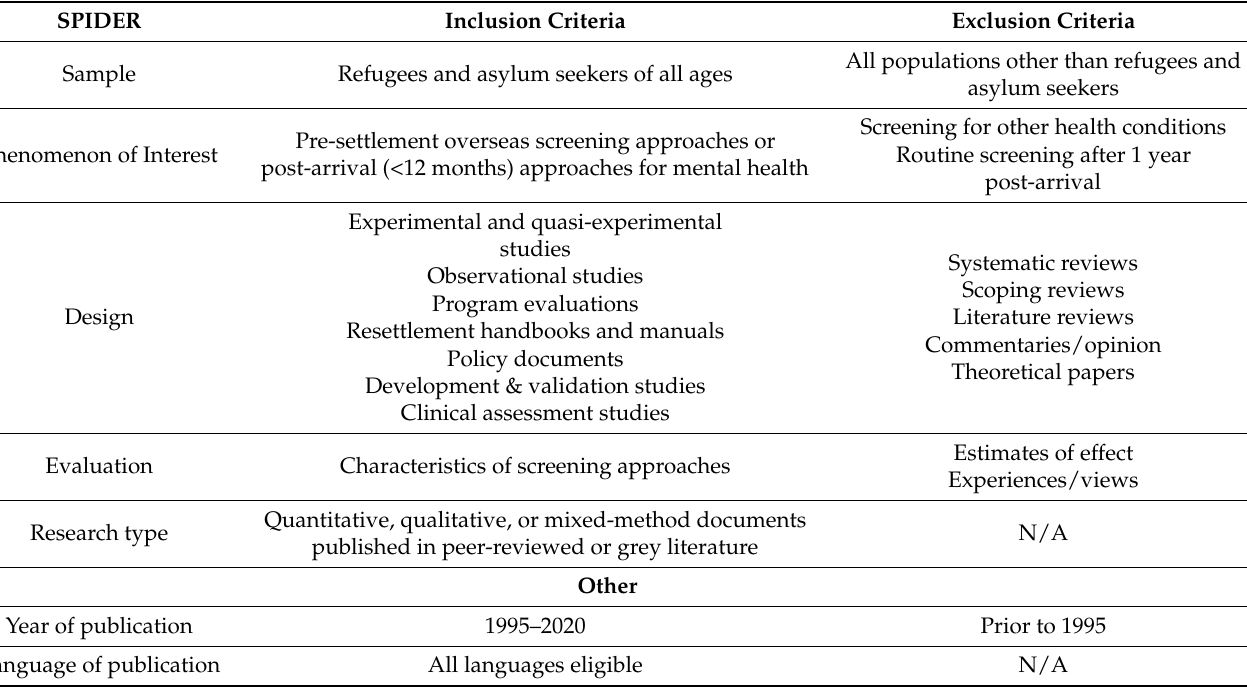
Table 1. Eligibility